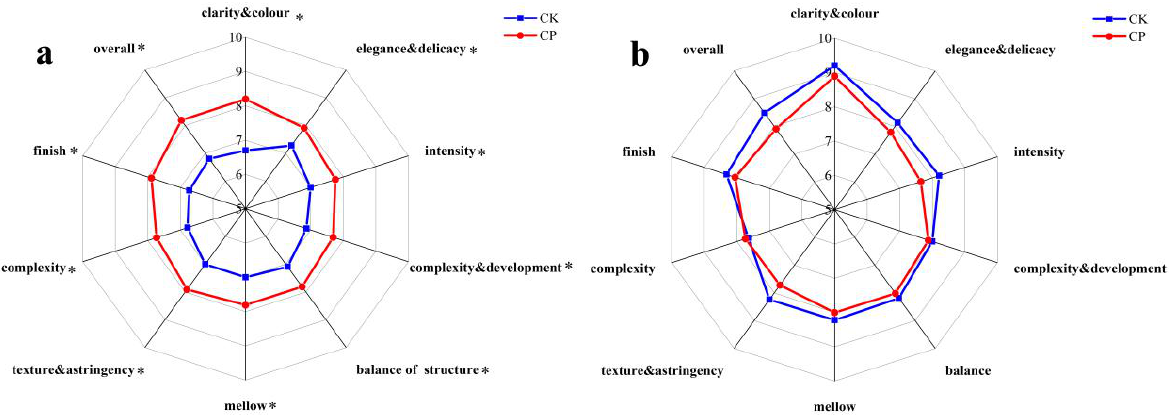
Figure 9. Influence of covering purslane on the aroma profiles and odor activity values (OAVs) in their wines. ( a ) aroma profiles in wines of the year 2018, ( b ) aroma profiles in wines of the year 2019; ( c ) OAVs of main aroma compounds (OAV > 0.1) in the year 2018; ( d ) OAVs of main aroma compounds (OAV > 0.1) in the year of 2019. * indicates significant differences between the wines of the control and covering purslane ( p < 0.05, t -test).